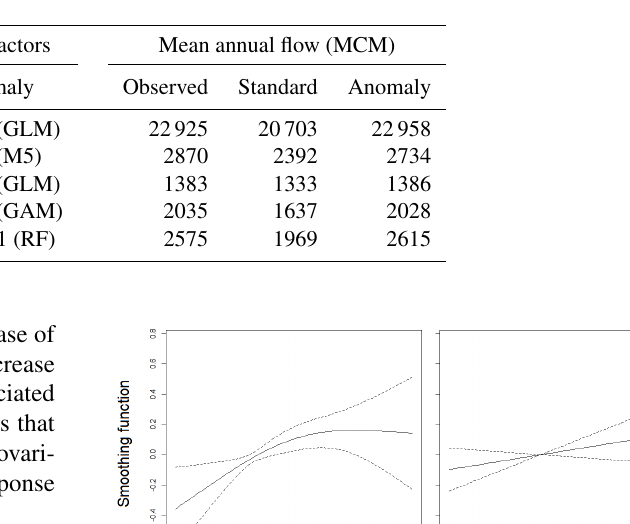
Table 4. Residual autocorrelation factors at a 12-month lag for the highest performing standard-formulation and anomaly-formulation models in each basin (with model type in parentheses), and resulting mean annual observed and predicted flow.